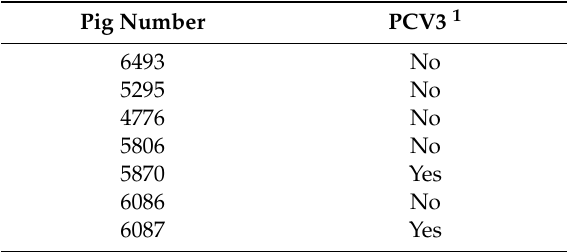
Table 3. Detection of PCV3 in animals from the herd in March